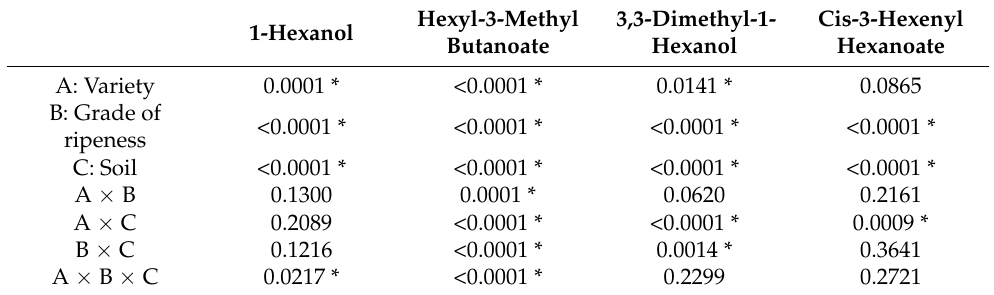
Table 4. Effect of factors and their respective interaction ( p values) for each of the volatile